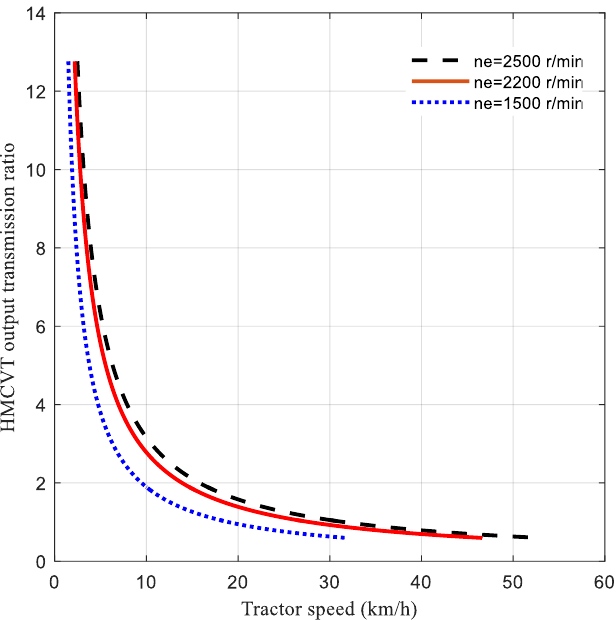
Figure 5. Relationship between HMCVT transmission ratio and vehicle speed at different engine speeds.